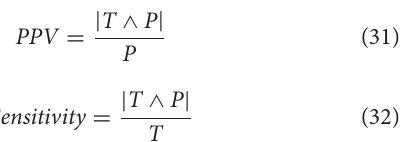
Frontiers in Neuroscience |